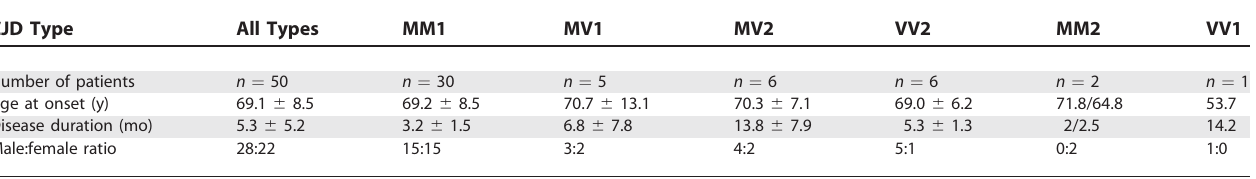
Table 1. Demographic Characteristics and Classification of Patients with sCJD Included in the